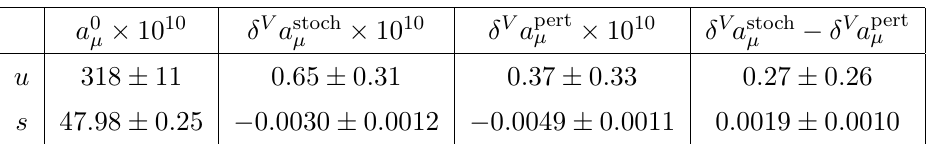
Table 4 . The HVP contribution to a (cid:22) without QED and the QED corrections from stochastic and perturbative data at an isospin symmetric pion mass of 340 MeV. Results have been obtained using Pad(cid:19)e R 11 .